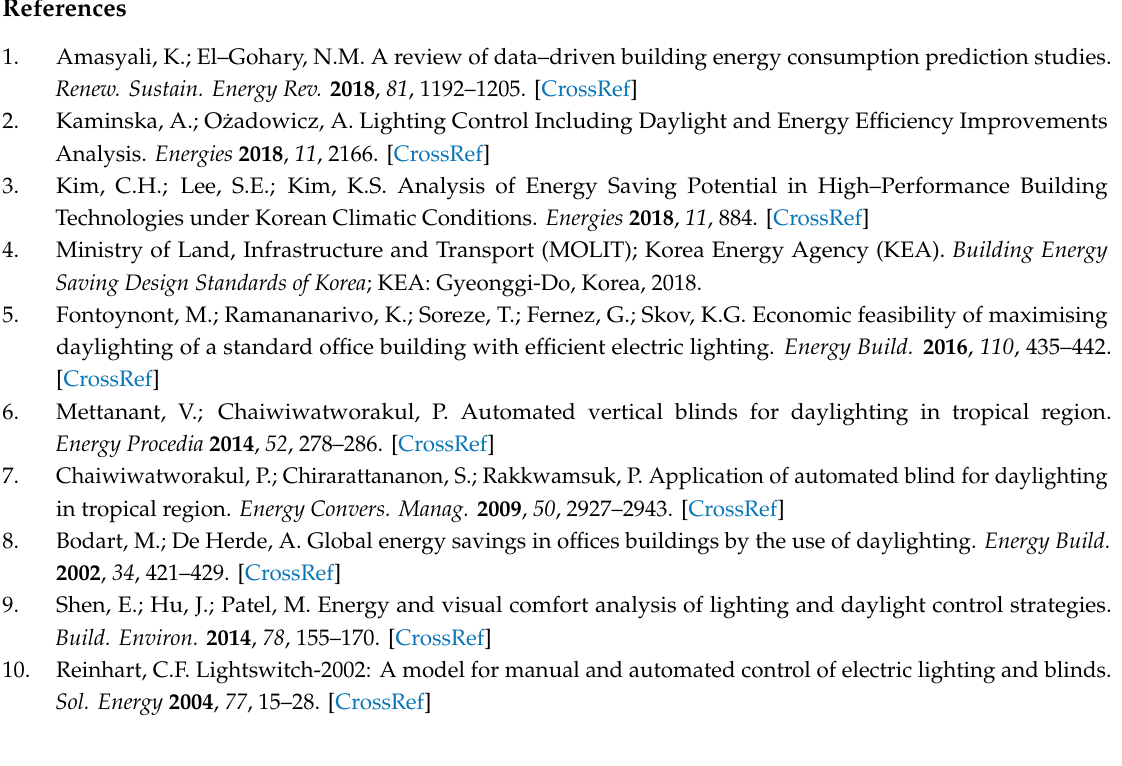
Table S1. Raw data for Illuminance and dimming rate under dimming control with no blinds (clear sky-1), Table S2. Raw data for Illuminance and dimming rate under dimming control with no blinds (intermediate sky), Table S3. Raw data for Illuminance and dimming rate under dimming control with no blinds (overcast sky), Table S4. Raw data for Illuminance and dimming rate under dimming control with no blinds (clear sky-2), Table S5. Raw data for Illuminance and dimming rates under dimming controls integrated with manual blind controls (100%–0 ◦ , clear sky), Table S6. Raw data for Illuminance and dimming rates under dimming controls integrated with manual blind controls (100%–0 ◦ , intermediate sky), Table S7. Raw data for Illuminance and dimming rates under dimming controls integrated with manual blind controls (100%–45 ◦ , clear sky), Table S8. Raw data for Illuminance and dimming rates under dimming controls integrated with manual blind controls (100%–45 ◦ , intermediate sky), Table S9. Raw data for Illuminance and dimming rates under dimming controls integrated with manual blind controls (50%–0 ◦ , clear sky), Table S10. Raw data for Illuminance and dimming rates under dimming controls integrated with manual blind controls (50%–0 ◦ , intermediate sky), Table S11. Raw data for Illuminance and dimming rates under dimming controls integrated with manual blind controls (50%–45 ◦ , clear sky), Table S12. Raw data for Illuminance and dimming rates under dimming controls integrated with manual blind controls (50%–45 ◦ , intermediate sky), Table S13. Raw data for Illuminance and dimming rates under dimming controls integrated with automatic blind controls (3-steps, clear sky), Table S14. Raw data for Illuminance and dimming rates under dimming controls integrated with automatic blind controls (4-steps, clear sky), Table S15. Raw data for Illuminance and dimming rates under dimming controls integrated with automatic blind controls (intermediate